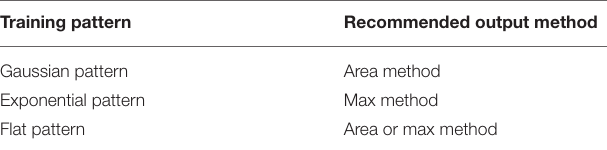
TABLE 4 | Recommended output determination methods for different training